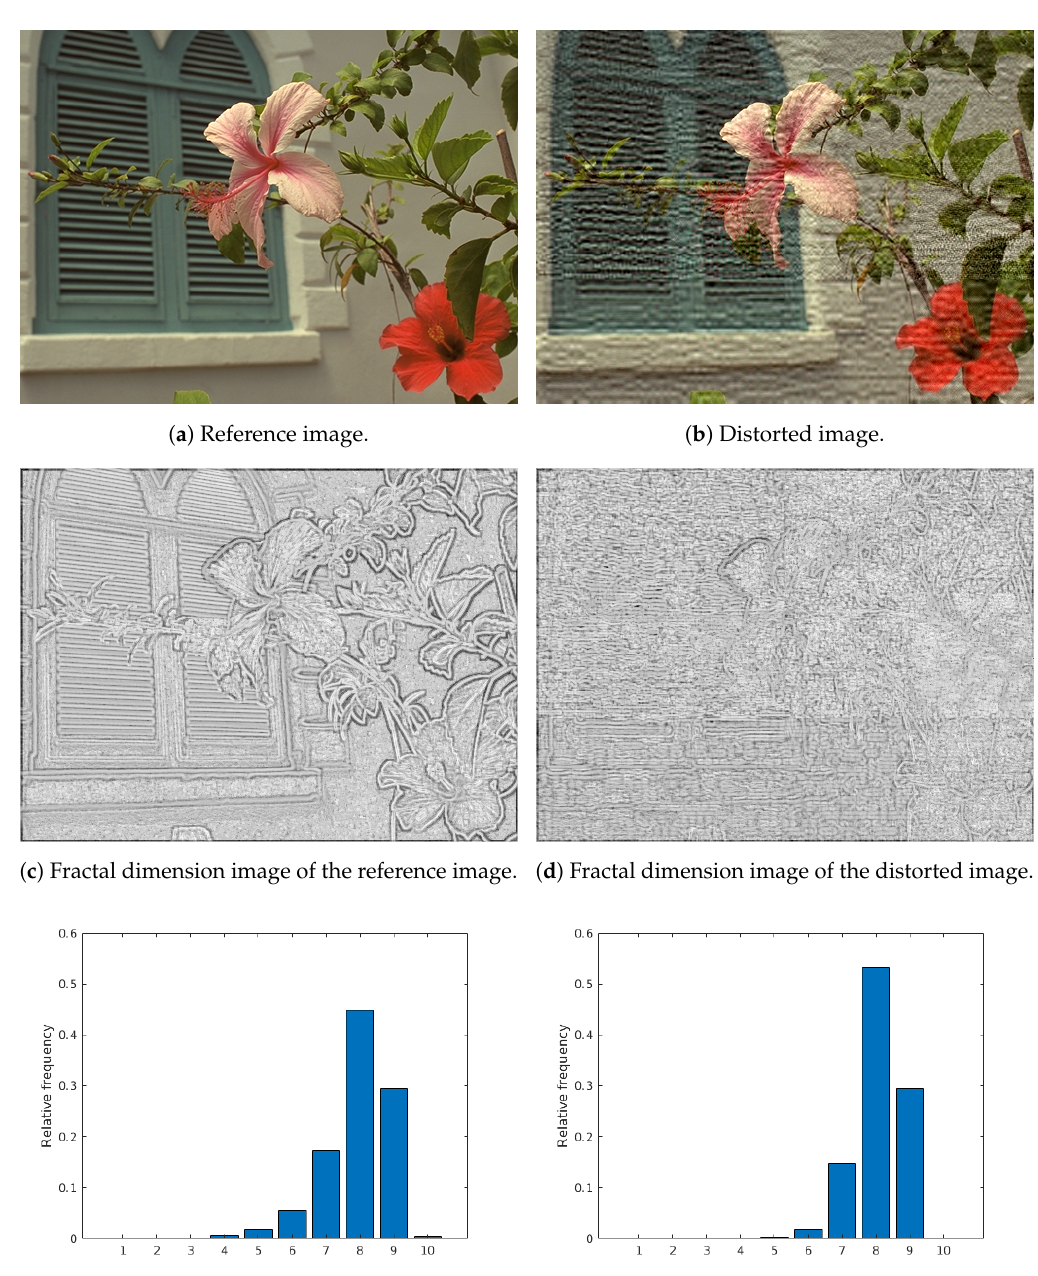
Figure 2. Illustration to fractal dimension distribution. Fractal dimension images are produced by considering each pixel in the original image as a center of a 7 × 7 patch and the fractal dimension is calculated from this patch. Furthermore, black pixels correspond to − 2 fractal dimension, while white ones correspond to +